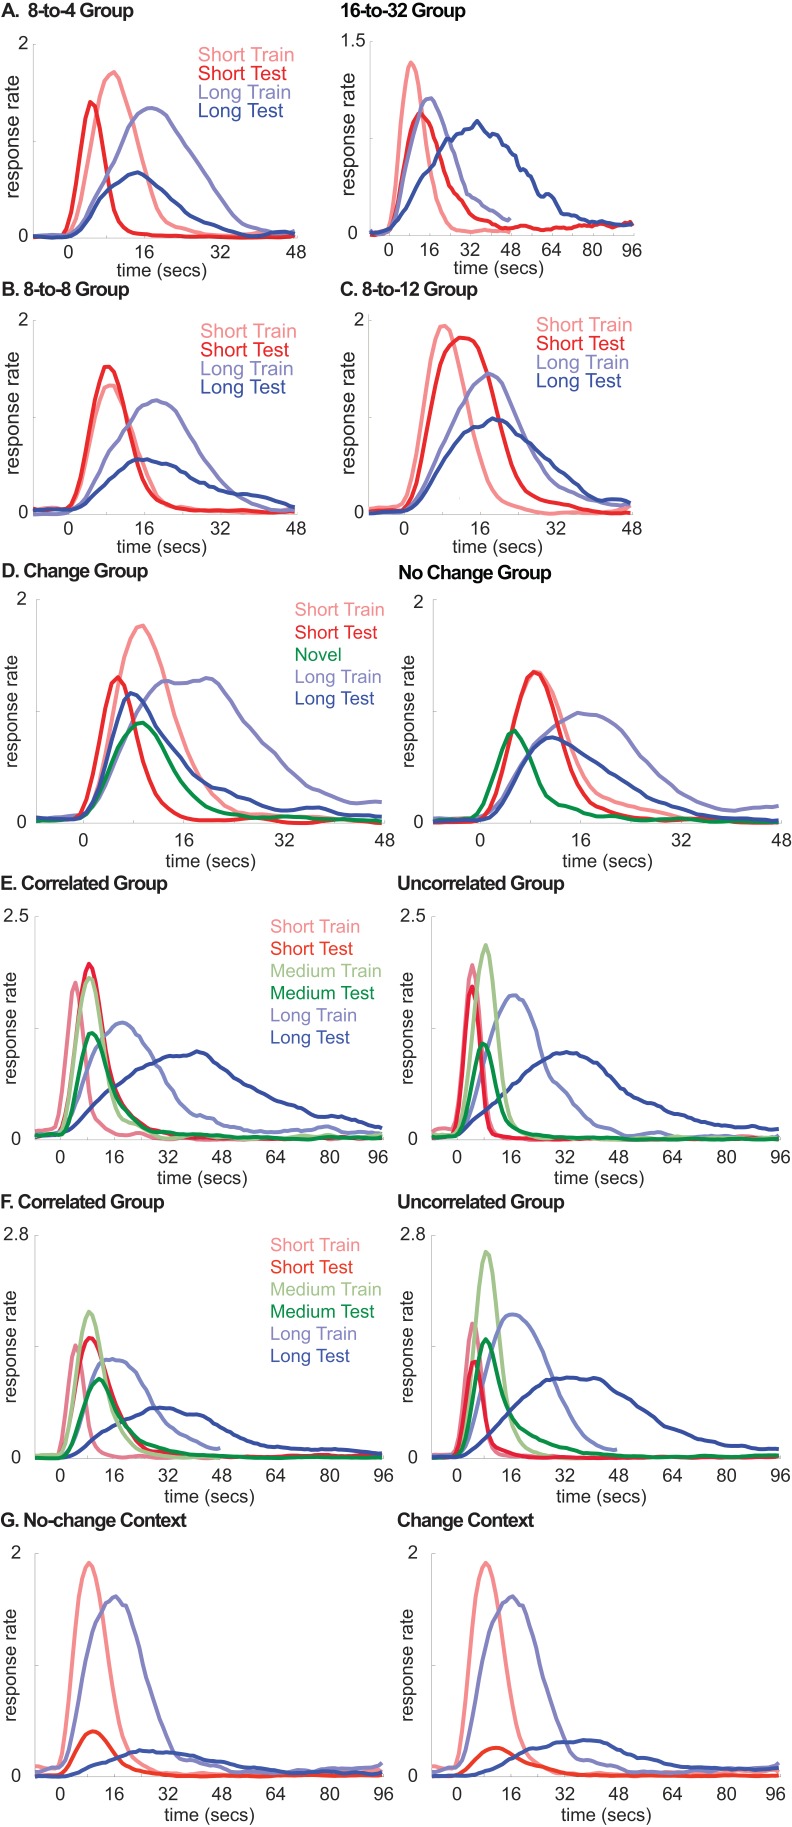
Raw probe trial response rates during training and testing for all experiments.A shows responding in the 8-to-4 (left) and 16-to-32 (right) groups of Experiment 1. B shows responding in the no-change control group of Experiment 1. (C) shows responding in the 8-to-12 group of Experiment 2. (D) shows responding for the change (left) and no-change (right) groups of Experiment 3. (E) shows responding in the correlated (left) and uncorrelated (right) groups of Experiment 4a. (F) shows the same for Experiment 4b. (G) shows responding during testing in the no-change (left) and change (right) contexts of Experiment 5.10.7554/eLife.38790.004Figure 1—figure supplement 1—source data 1.Data used to generate Figure 1—figure supplement 1.